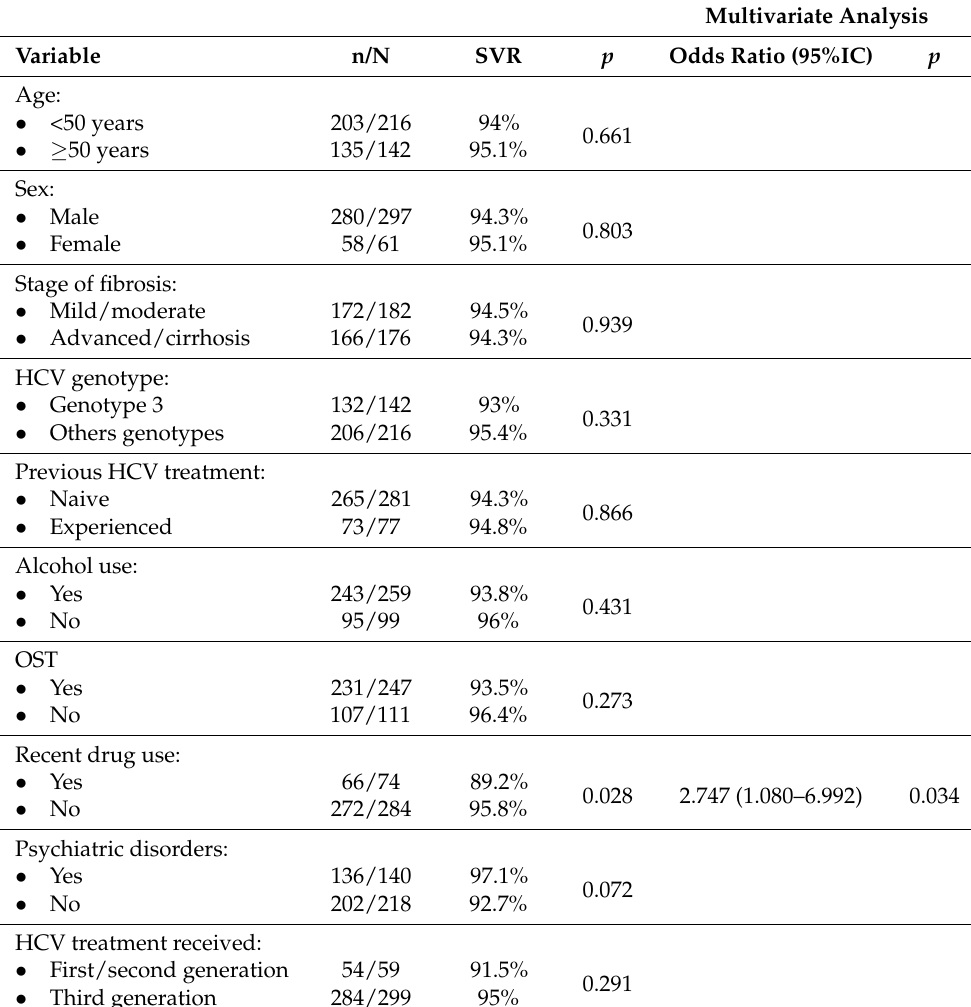
Table 3. Factors associated with failure treatment (according ITT analysis) to direct acting antiviral drug